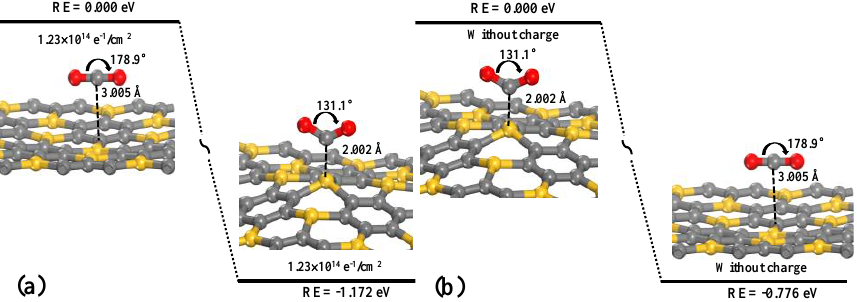
Figure 5. The process of ( a ) CO 2 adsorption on the SiC 3 nanosheet after injecting negative charges with density of 1.23 × 10 14 e − /cm 2 for the SiC 3 nanosheet with CO 2 adsorption, and ( b ) CO 2 desorption from the SiC 3 nanosheet after switching off the injection of negative charges.